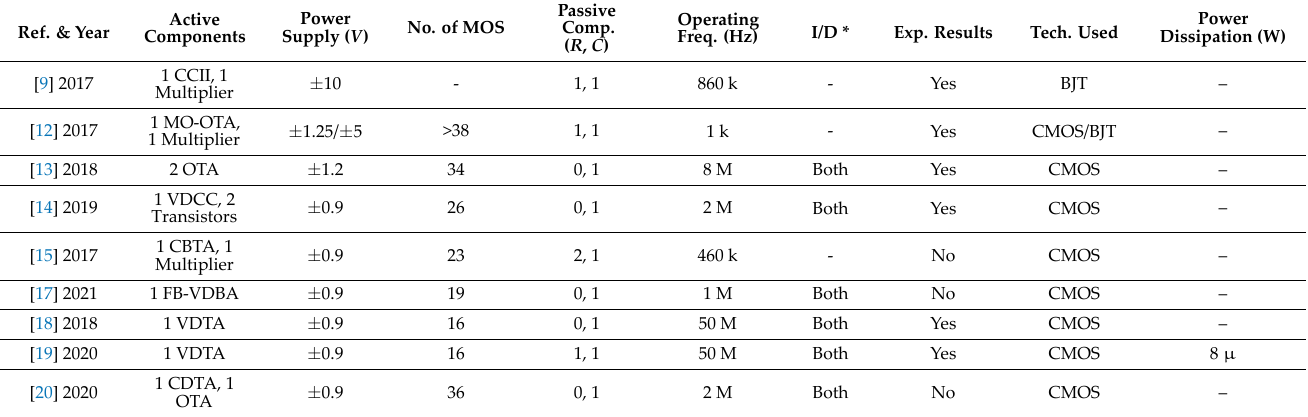
Table 1. Comparison of proposed memristor with available